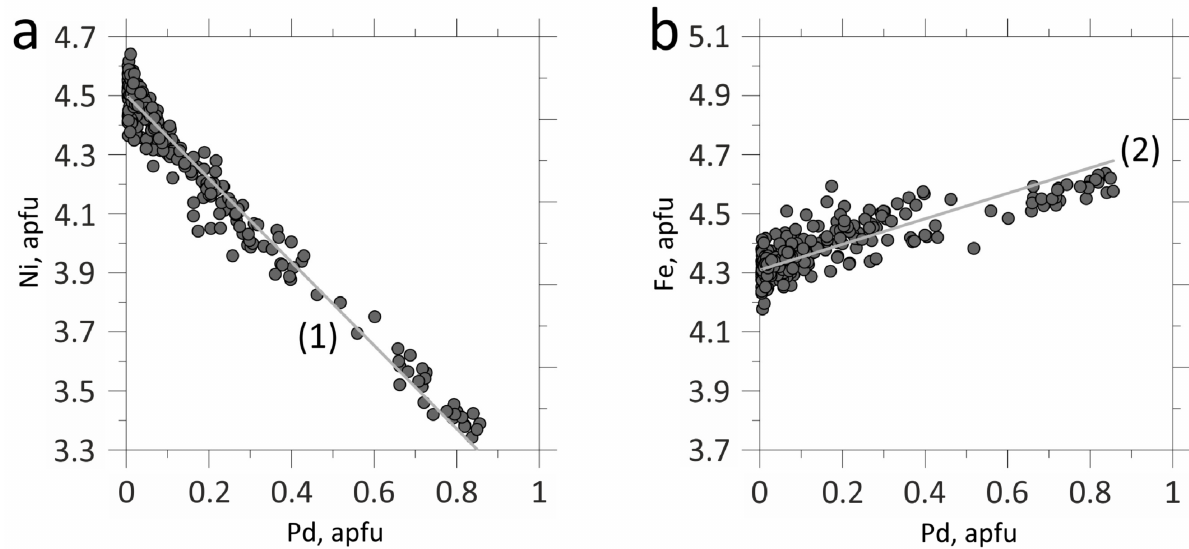
Figure 11. Binary diagrams, showing correlation between main elements in Pd-rich pentlandite: ( a ) Diagram Pd-Ni; ( b ) Dia- gram Pd-Fe. The lines marked with numbers (1) and (2) are plotted according to Deming regression Equations (1) and (2) in the text. Apfu—atoms per formula